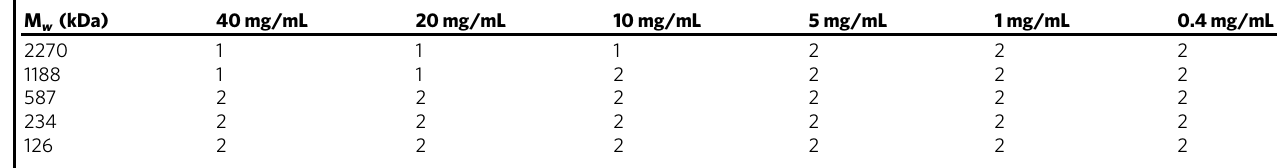
Table 1 Number of diffusive modes in the system with different M w and